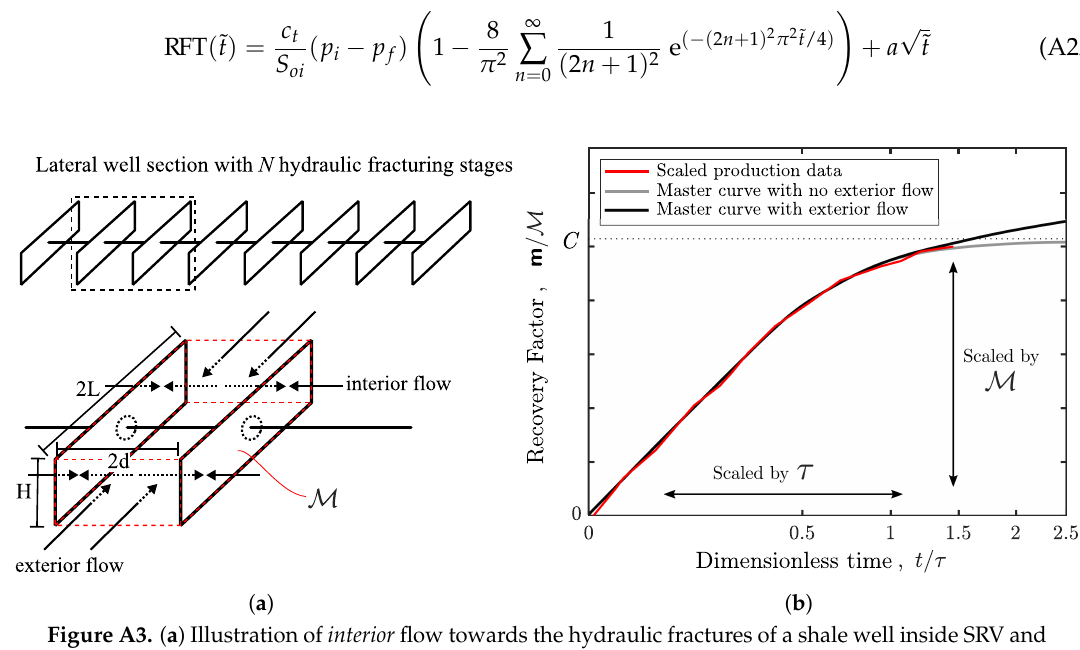
Figure A3. ( a ) Illustration of interior flow towards the hydraulic fractures of a shale well inside SRV and exterior flow from the reservoir beyond SRV. Adapted from Patzek et al. [25] and Eftekhari et al. [26] ( b ) Illustration of physical scaling approach of the interior and exterior oil production problem. Adapted from Saputra et al. [27]